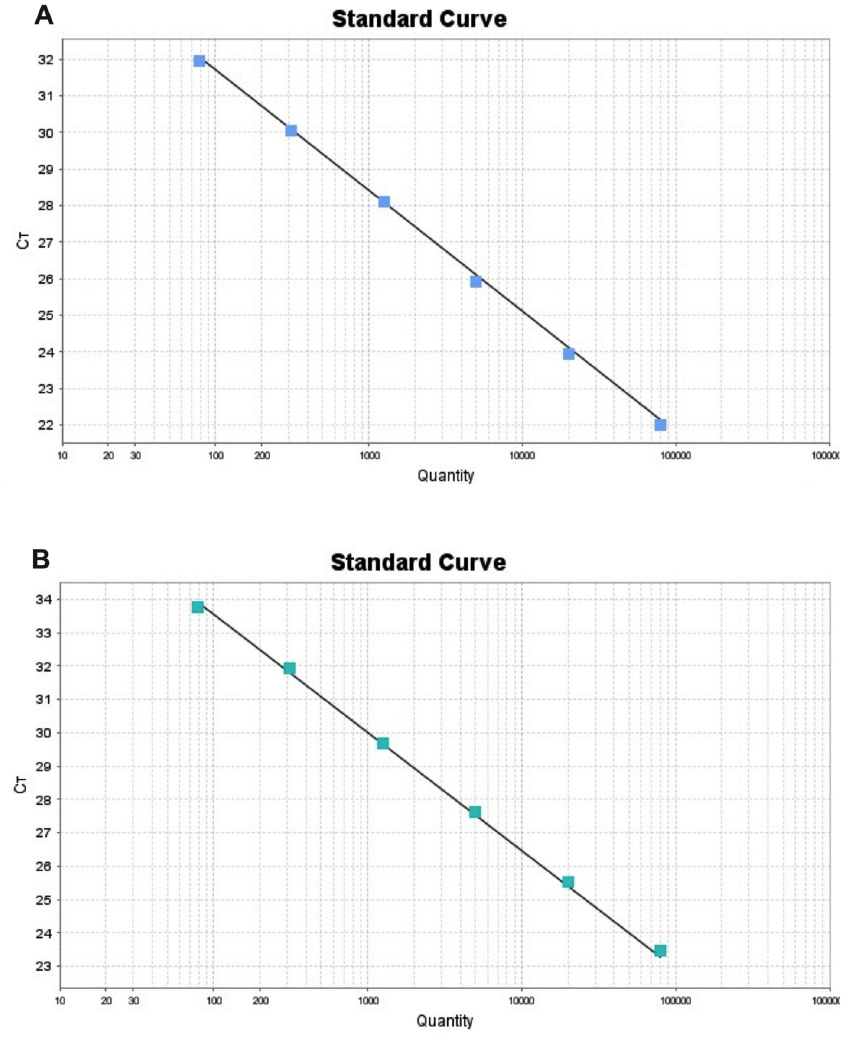
Fig 1. Dynamic extension of the SARS-CoV-2 N gene. (A) Standard curve for the target N1. (B) Standard curve for the target N2. Serial dilutions of synthetic DNA of the N gene were assayed in a 1:4 proportion for both